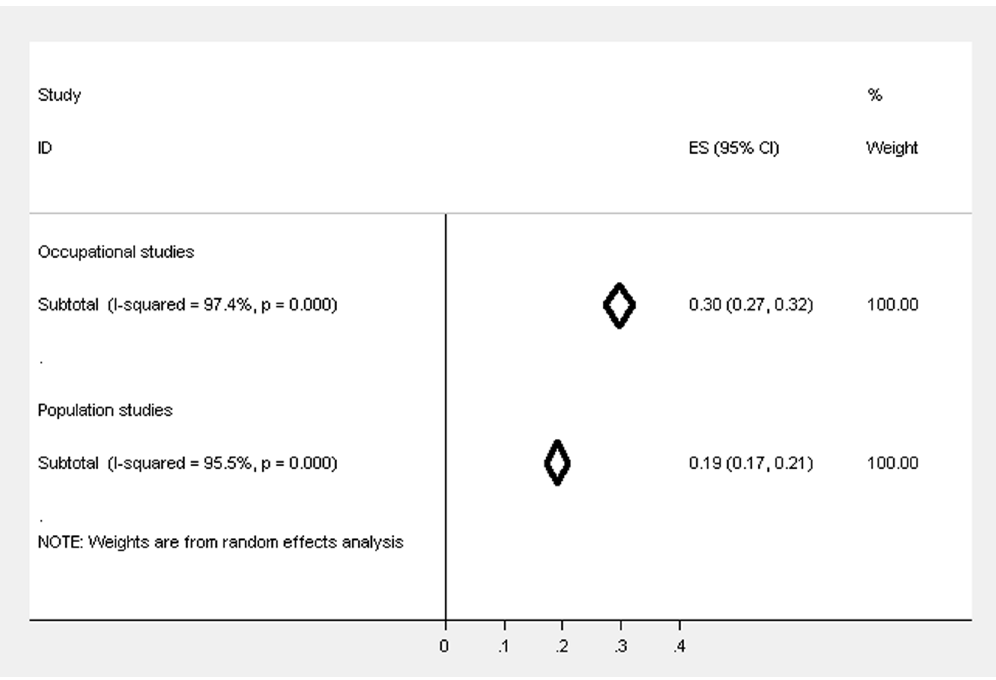
Figure 5. Forest plot displaying the weighted estimates for CMD caseness between the occupational and population studies (restricted to studies using GHQ-12 (3/4)).